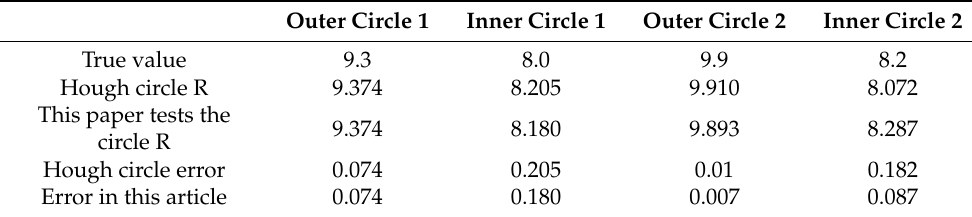
Table 3. Radius of Table 3. Radius of contrast.